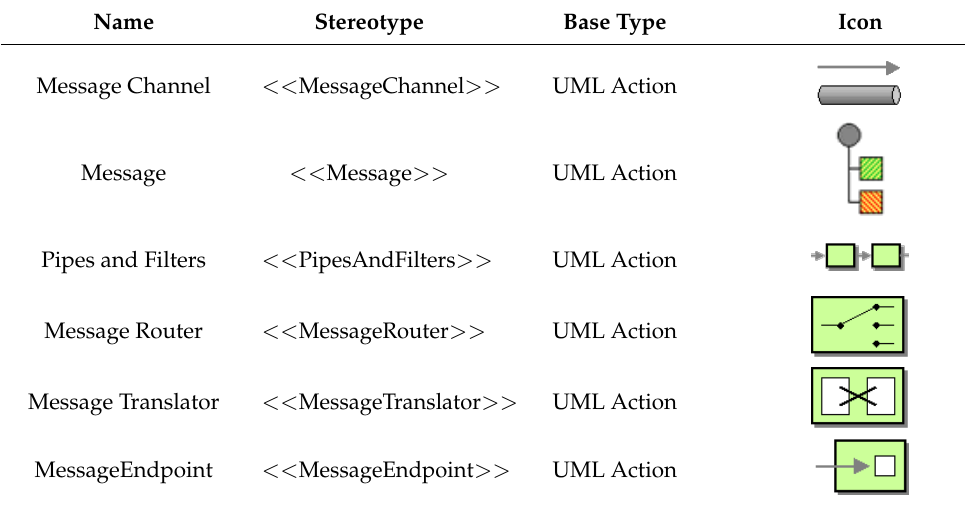
Table 2. Stereotypes with icons for the patterns in the messaging system